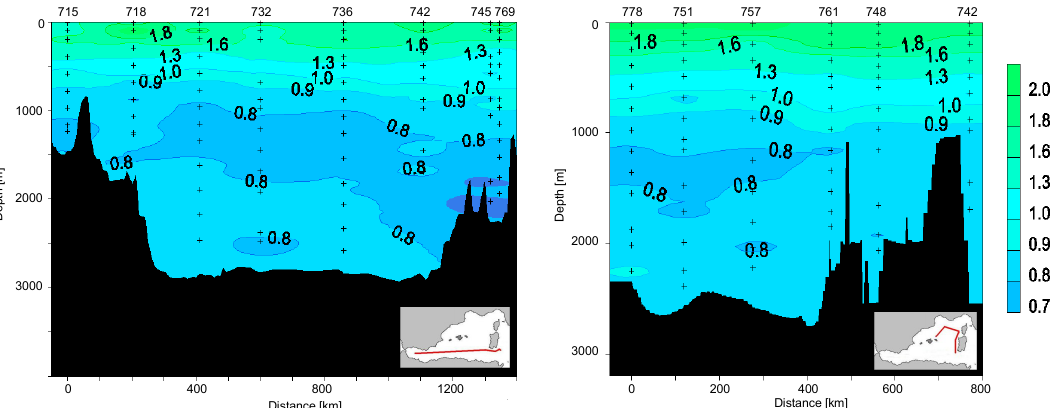
Fig. 4. Tritium sections (TU) of Poseidon 234, 1997, left extended southern section, right northern curved section. Numbers on top are station numbers, station positions see inset maps.